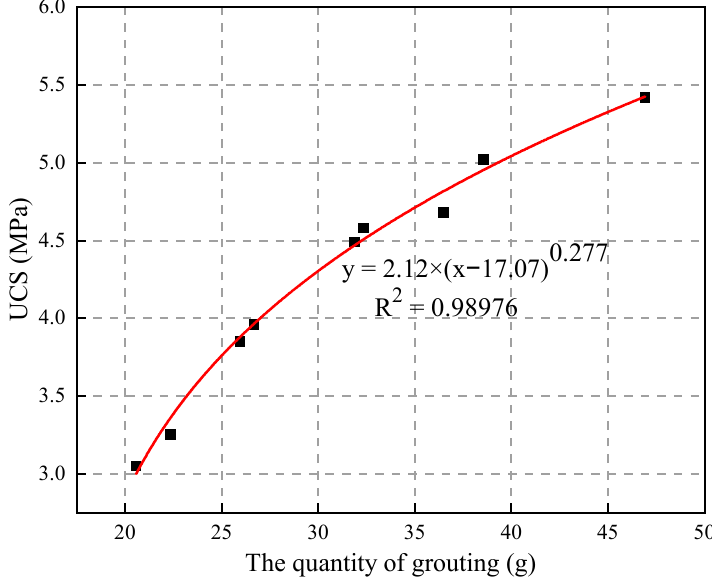
Figure 5. The relationship between grouting quantity and UCS.